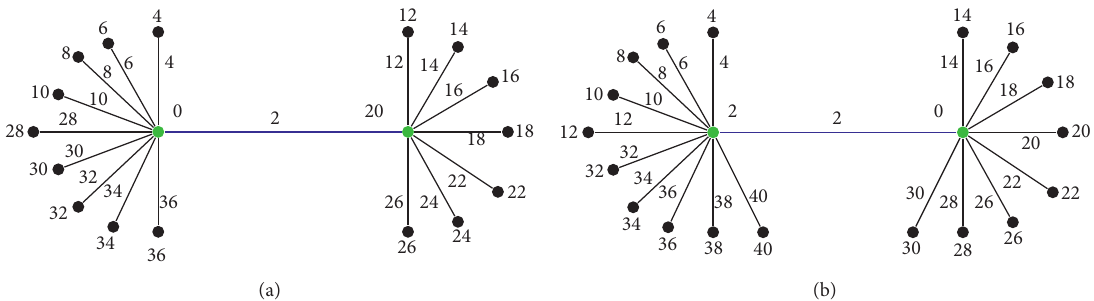
Figure 10: (a) A 2-edge even labeling of B